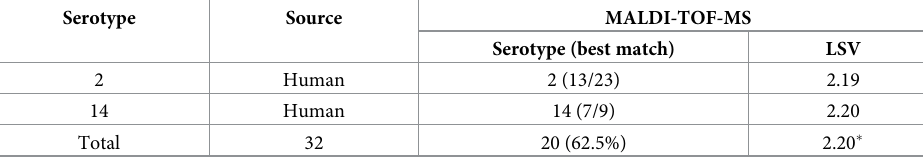
� Average LSV of correct MALDI-TOF-MS